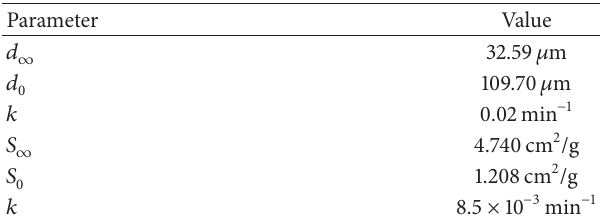
Table 3: The characteristic parameters of the micronized